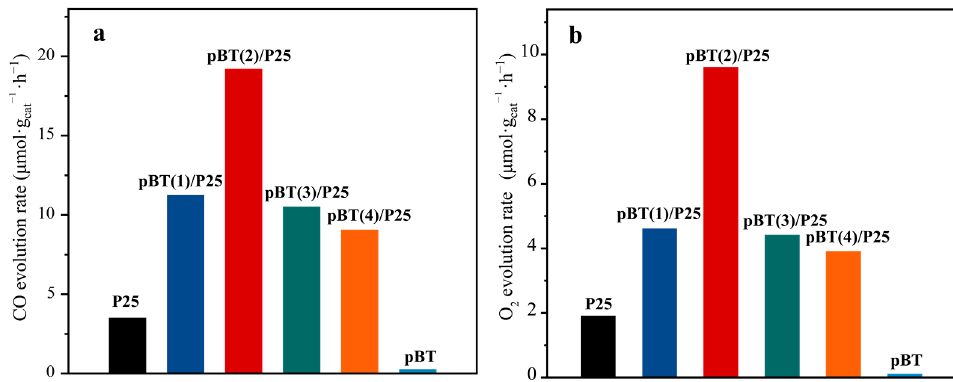
Figure 4. ( a ) CO and ( b ) O 2 evolution rates over P25, pBT(x)/P25, and pBT under a 300 W full-arc Xe lamp illumination.